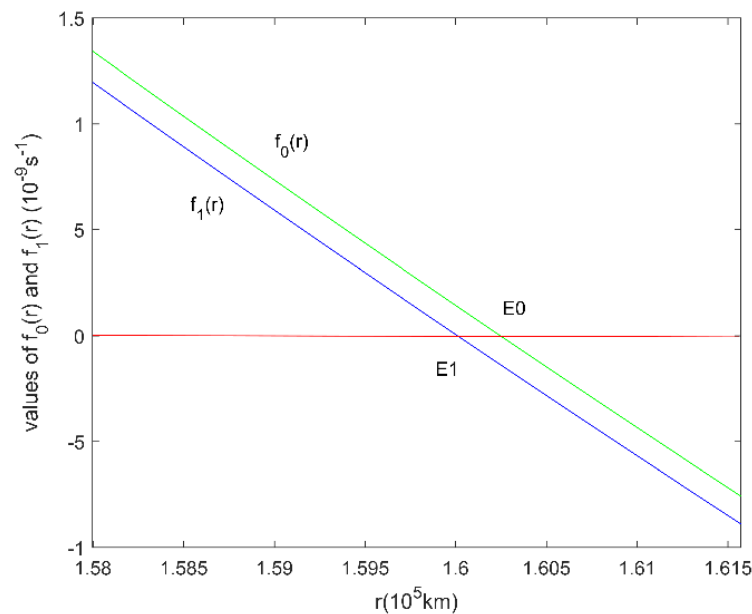
( ), ( ) f r f r as r increases from 2.2 R to 2.3 R . Figure 1. Variations of f 0 ( r ) , f 1 ( r ) as r increases from 2.2 R to 2.3 R 0 1